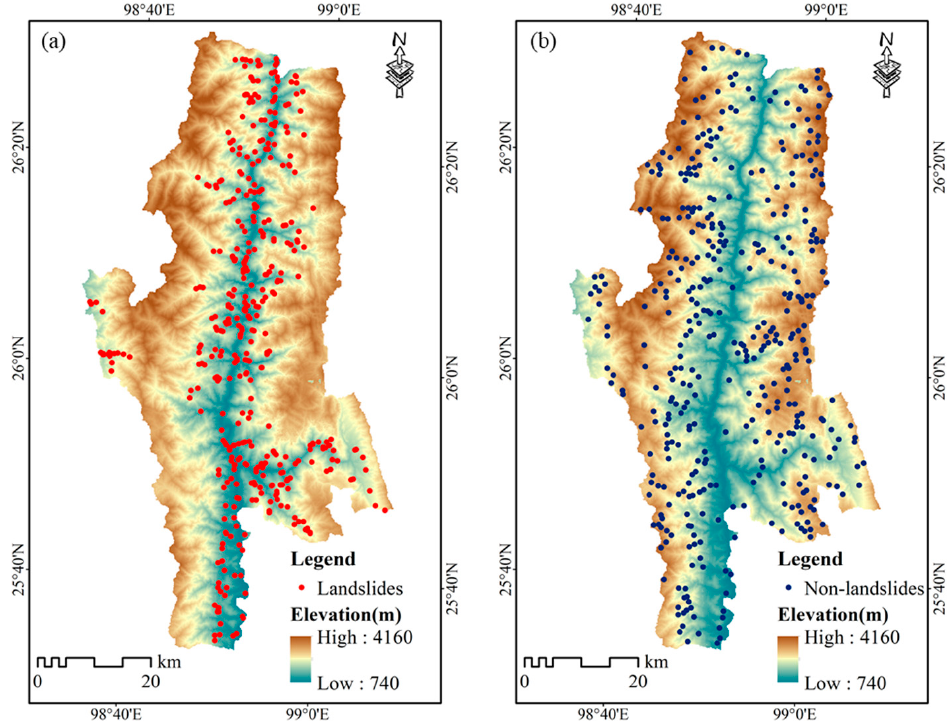
Figure 4. ( a ) Locations of landslide; ( b ) Locations of non-landslide.